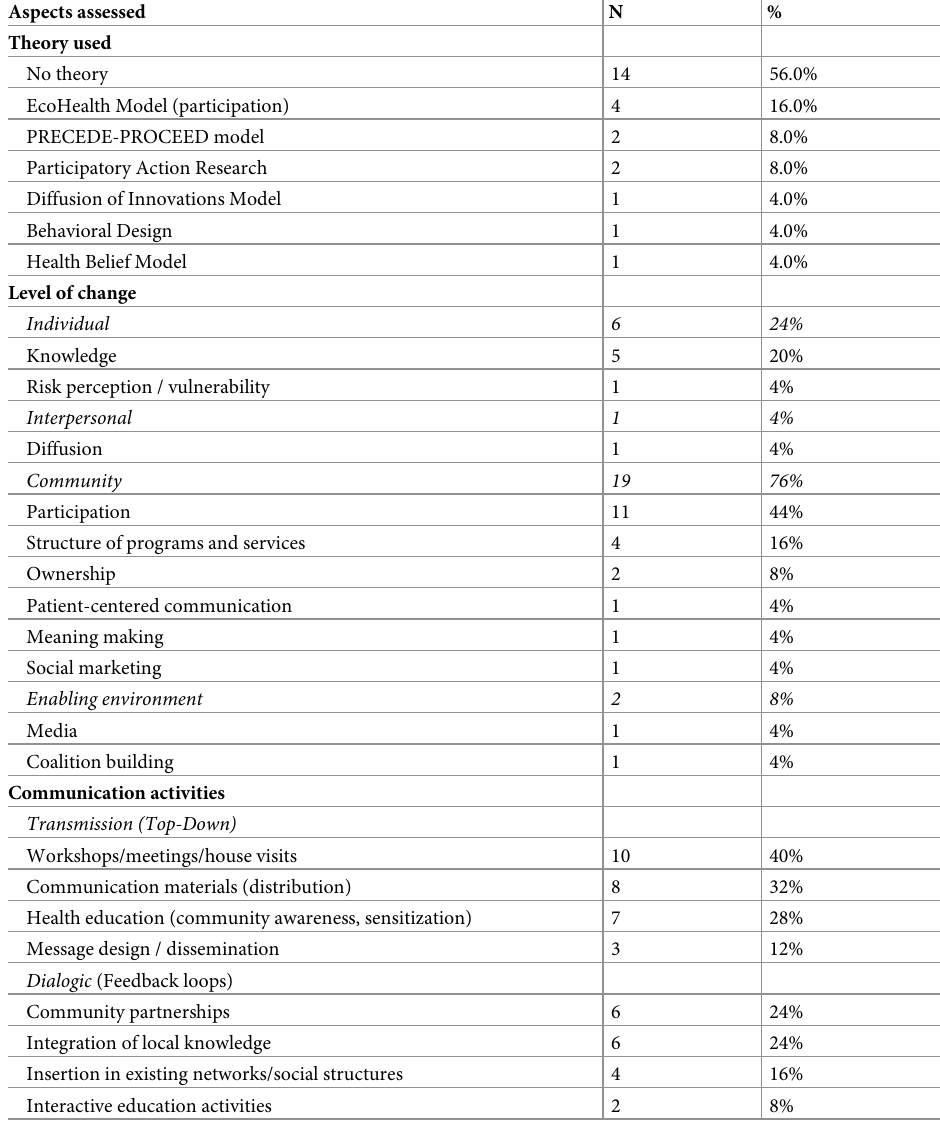
� Totals and percentages within level of change and communication do not total to 25 to account for multiple levels/ activities reported in an article. See S3 Table for additional